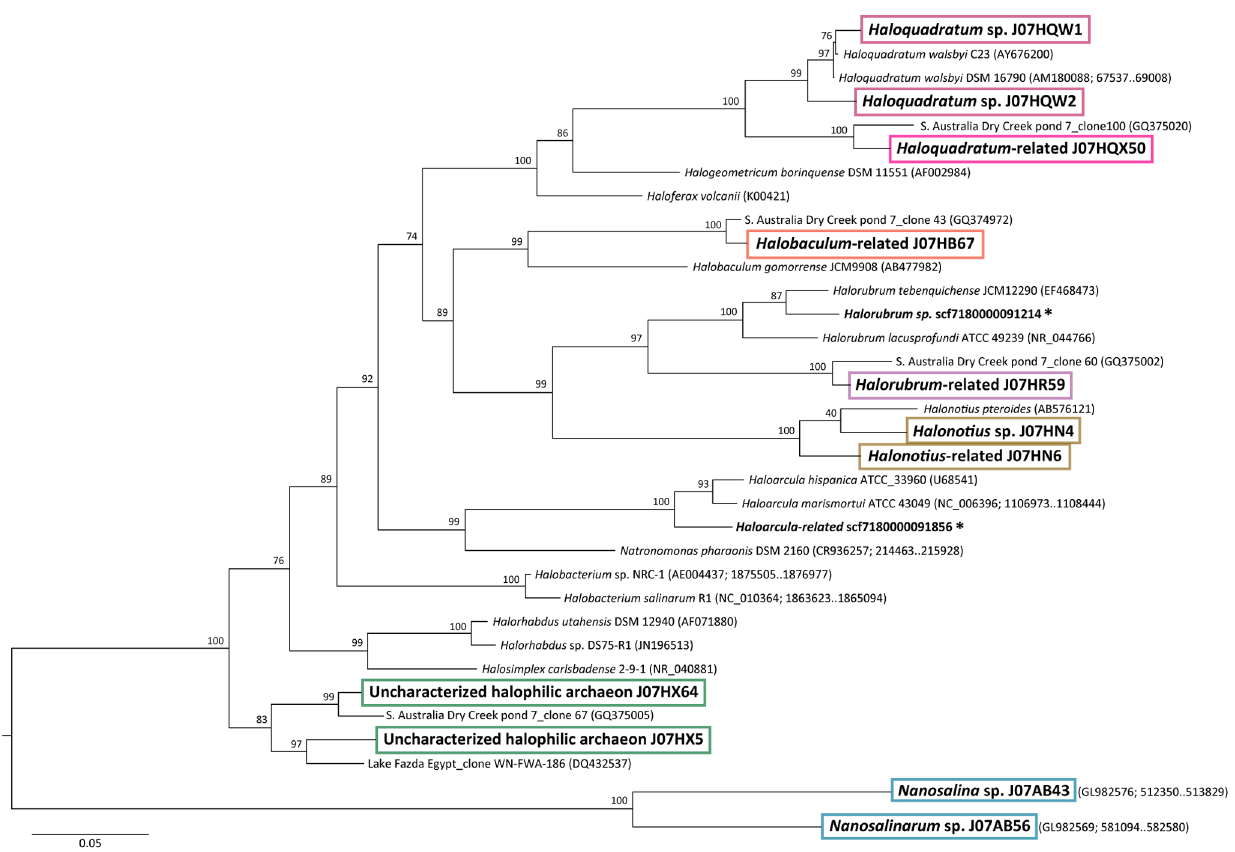
Figure 2. Phylogenetic distribution of archaeal 16S rRNA gene sequences in assembled scaffolds and population genomes. Names in bold indicate new 16S rRNA sequences identified in this study. Boxed names indicate sequences contained within Lake Tyrrell-specific population genomes. Asterisks indicate isolated individual sequences found on small scaffolds that were not associated with any assembled population genome.